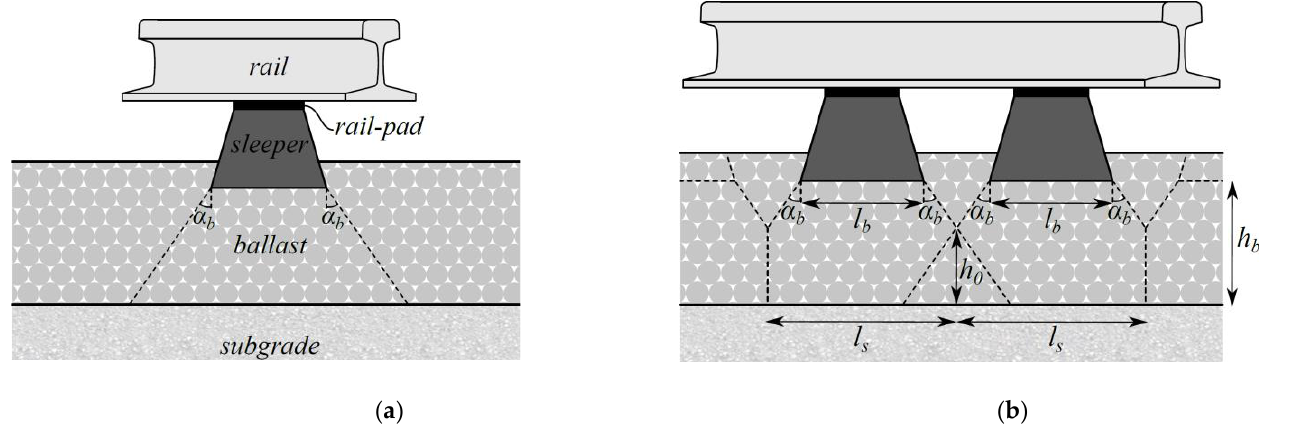
Figure 2. Stress cone load distribution in the ballast, adapted from [3]: ( a ) without superposition; ( b ) with superposition. No functional dependence is proposed for all damping coefficients (